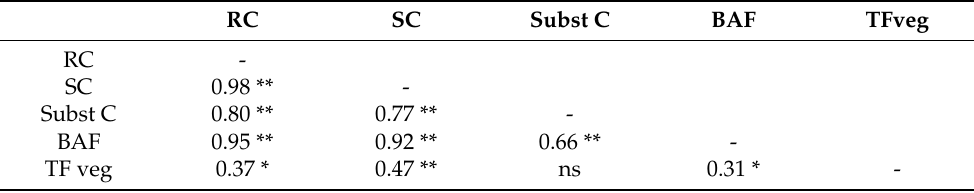
Table 9. Pearson correlation between main variables at vegetative stage of Vicia faba